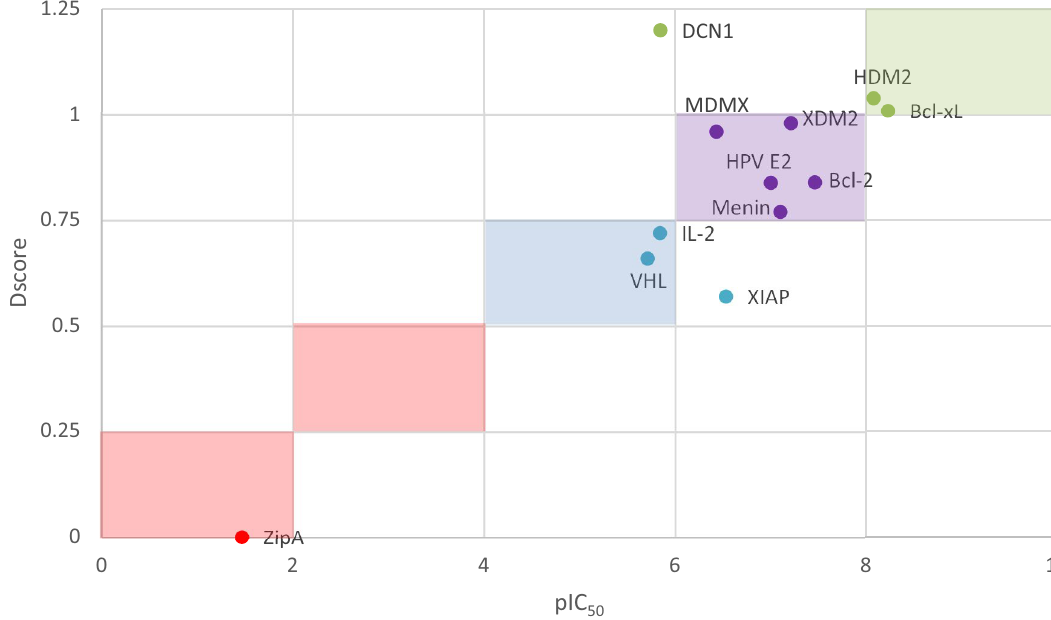
Figure 2. Scatter plot of mean Dscore and mean pIC50 values for each target in the proposed dataset. Dscore ≥ 1.0: very druggable (green points); Dscore ≥ 0.75 and < 1.0: druggable (purple); Dscore ≥ 0.5 and < 0.75: moderately druggable (blue); Dscore < 0.5: difficult (red). ZipA values were undefined and hence assigned a value of